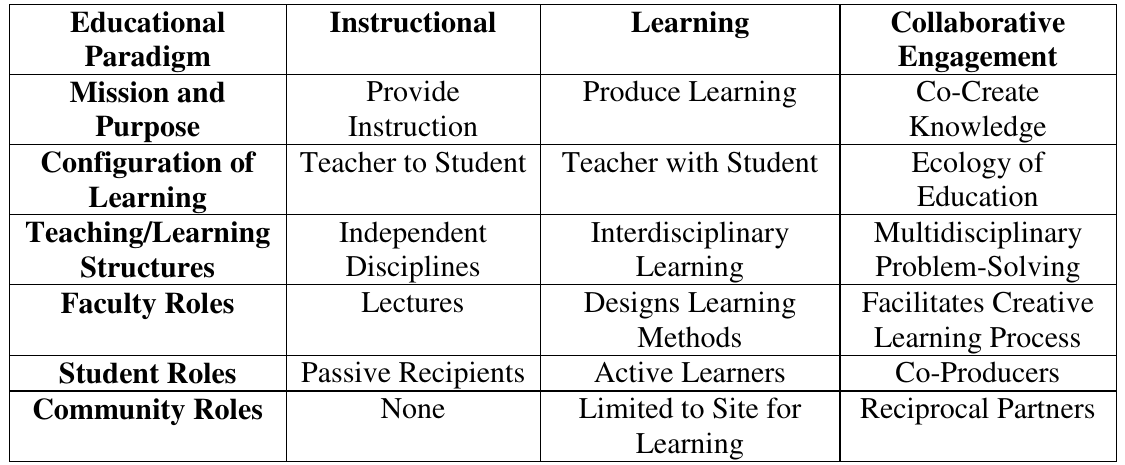
Figure Two: Approaches to Teaching and